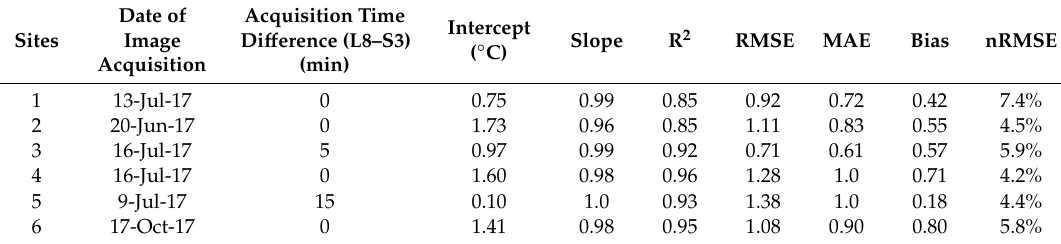
Figure 4. Relationship between two BTs derived from Landsat 8 and Sentinel-3 at a coarse spatial resolution (960 m) for: ( a ) Site 1, ( b ) site 2, ( c ) site 3, ( d ) site 4, ( e ) site 5, and ( f ) site 6. The black line represents the regression line. The dashed red line is the graph 1:1 line. Table 2. Quantitative analysis of the differences between the simulated Landsat 8 thermal data and Sentinel-3 TM data at a coarse spatial resolution. The statistics include: the regression coefficients slope and intercept, coefficient of determination (R 2 ), root mean square error (RMSE), mean absolute